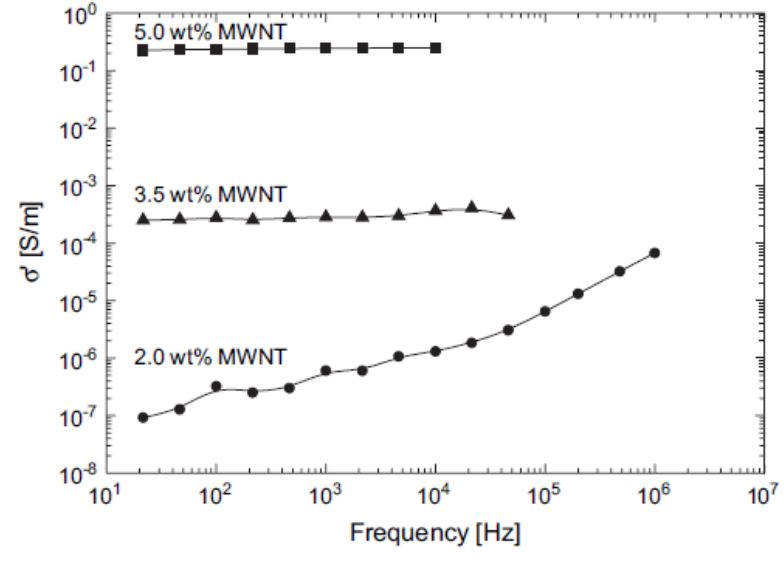
Figure 28. Conductivity spectra for polypropylene carbon nanotube composites with different MWCNTs contents recorded at about 120 s after the extruder was stopped. The temperature of the slit die was about 225 °C. Reproduced with permission from ref.